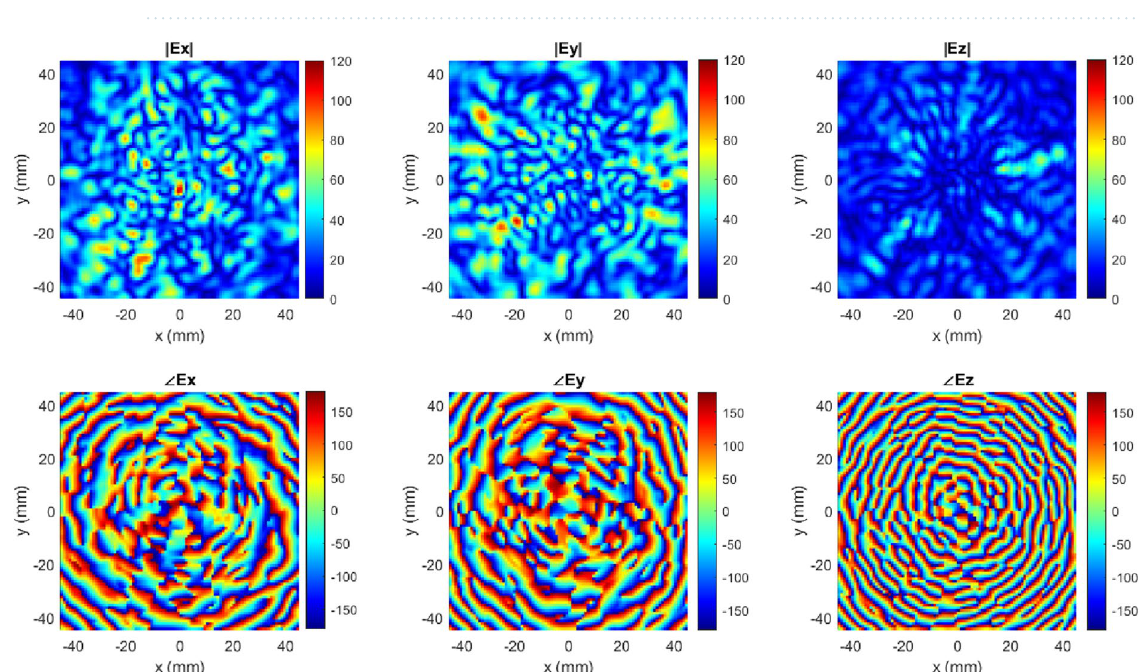
Figure 7. Simulated x , y and z components of E -field (V/m) in terms of magnitude and phase contour